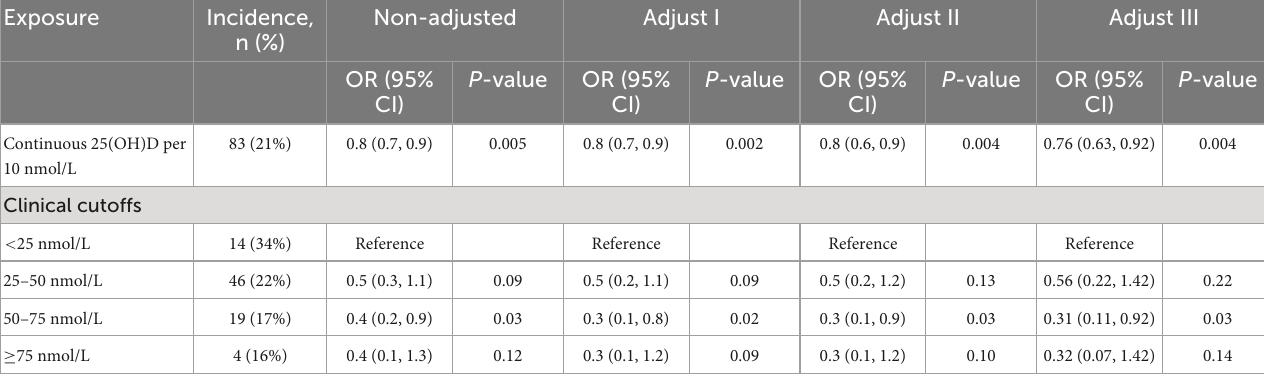
Non-adjusted Adjust I Adjust II Adjust III n (%) OR (95% P -value OR (95% P -value OR (95% P -value OR (95% P CI) CI) CI) CI)